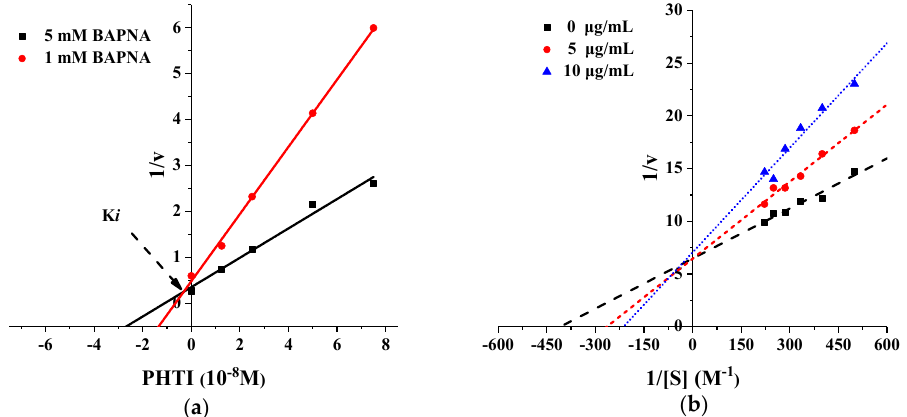
Figure 4. Inhibition kinetics of PHTI. ( a ) Dixon plot analysis. ( b ) Lineweaver–Burk plot analysis.